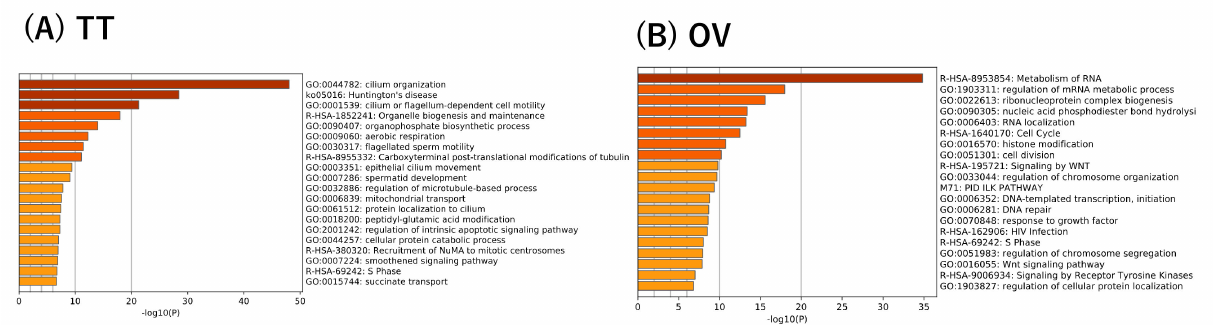
Figure 6. Results of the enrichment analysis by Metascape in the testis (TT) ( A ) and ovary (OV) ( B ). An enrichment analysis was performed using annotation data against the human gene set of the reference transcripts expressed in specific tissues. − log10 (P) represents − log10 ( p -value). For example, − log10 ( p ) = 5 represents p -value = 10 − 5